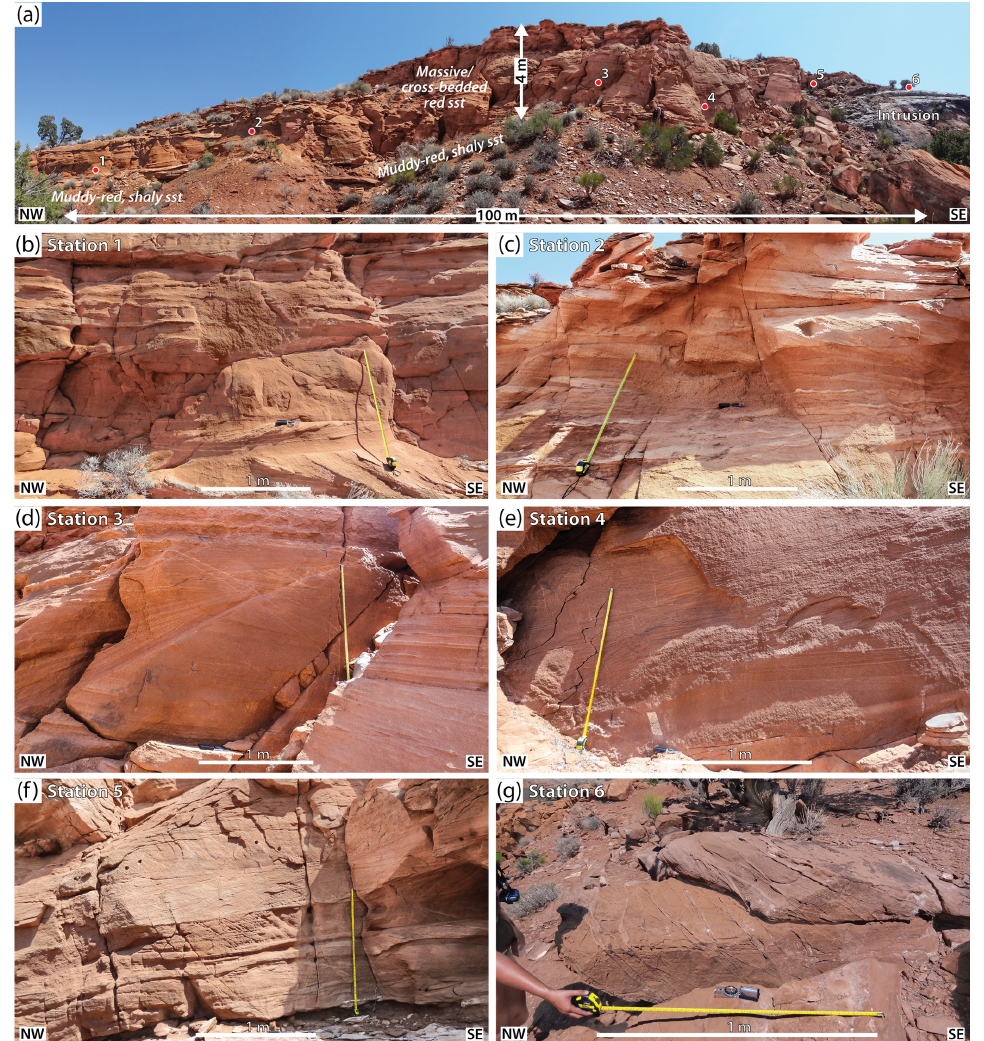
Figure 2. Sampling traverse across lateral margin of the Trachyte Mesa intrusion. (a) Panoramic photograph of study area. Note red, cross- bedded Entrada Sandstone unit, and Trachyte Mesa intrusion outcropping to the right. All structural stations lie within the same cross-bedded sandstone unit. Although this unit exhibits lateral and vertical variations in sedimentary structures, attempts were made to sample rocks with similar grain size, grain rounding, and mineralogy for this study. (b–g) Overview outcrop photographs for each